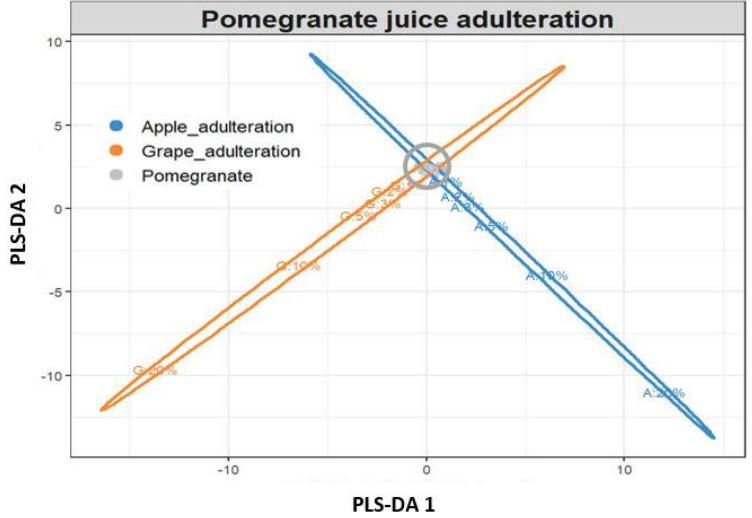
Figure 5. Partial least squares discriminant analysis (PLS-DA) plot showing the classification of authentic and adulterated pomegranate juice samples.